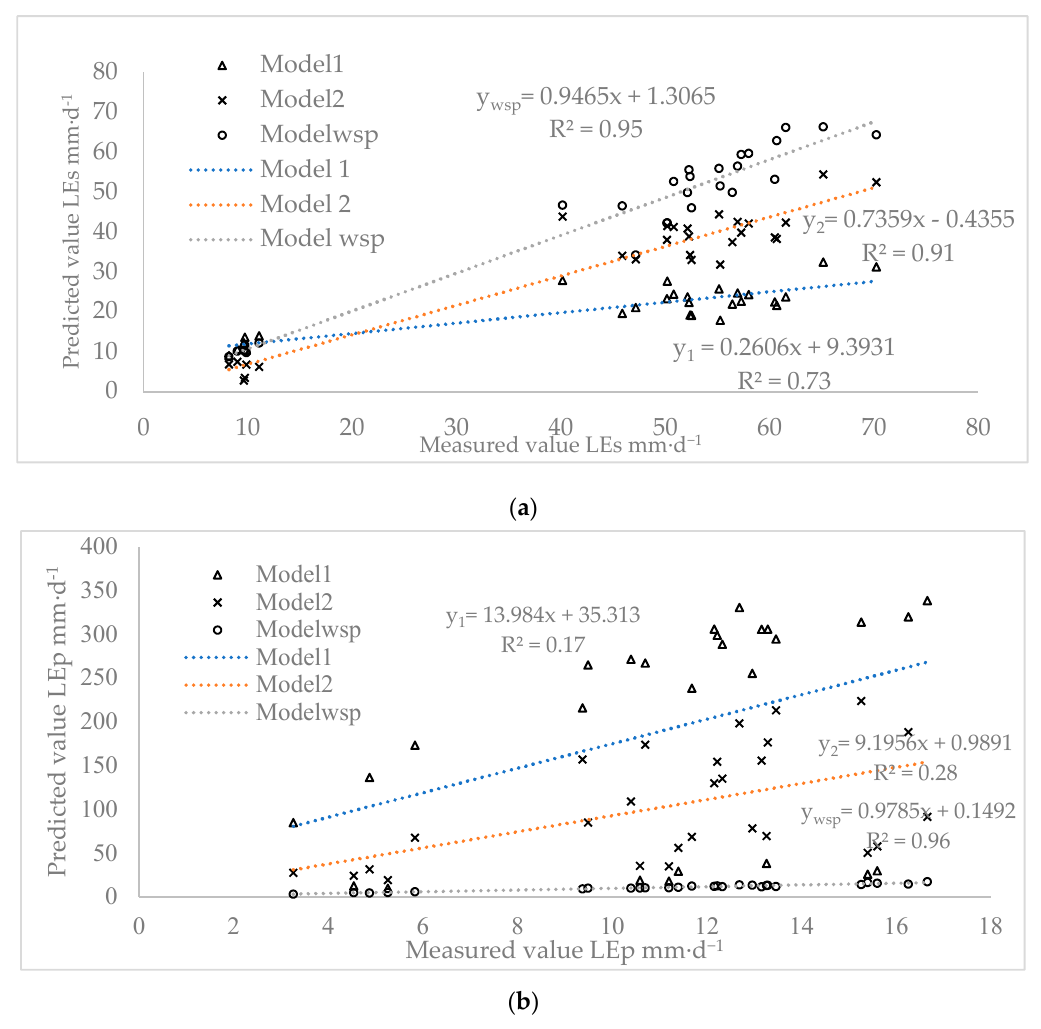
Figure 6. ( a ) The linear relationship between the predicted and measured values of LE s by the r wsp s model; ( b ) The linear relationship between the predicted and measured values of LE p by the r wsp s model.